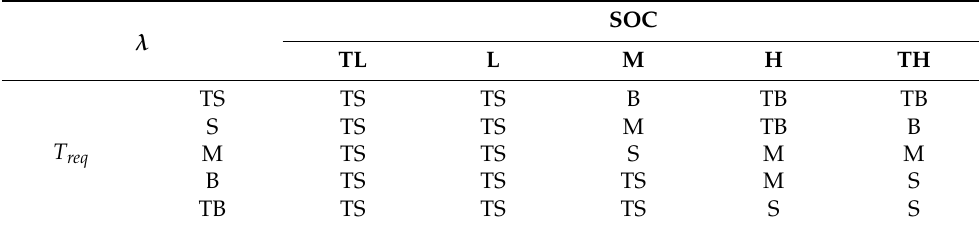
Table 5. Fuzzy rule